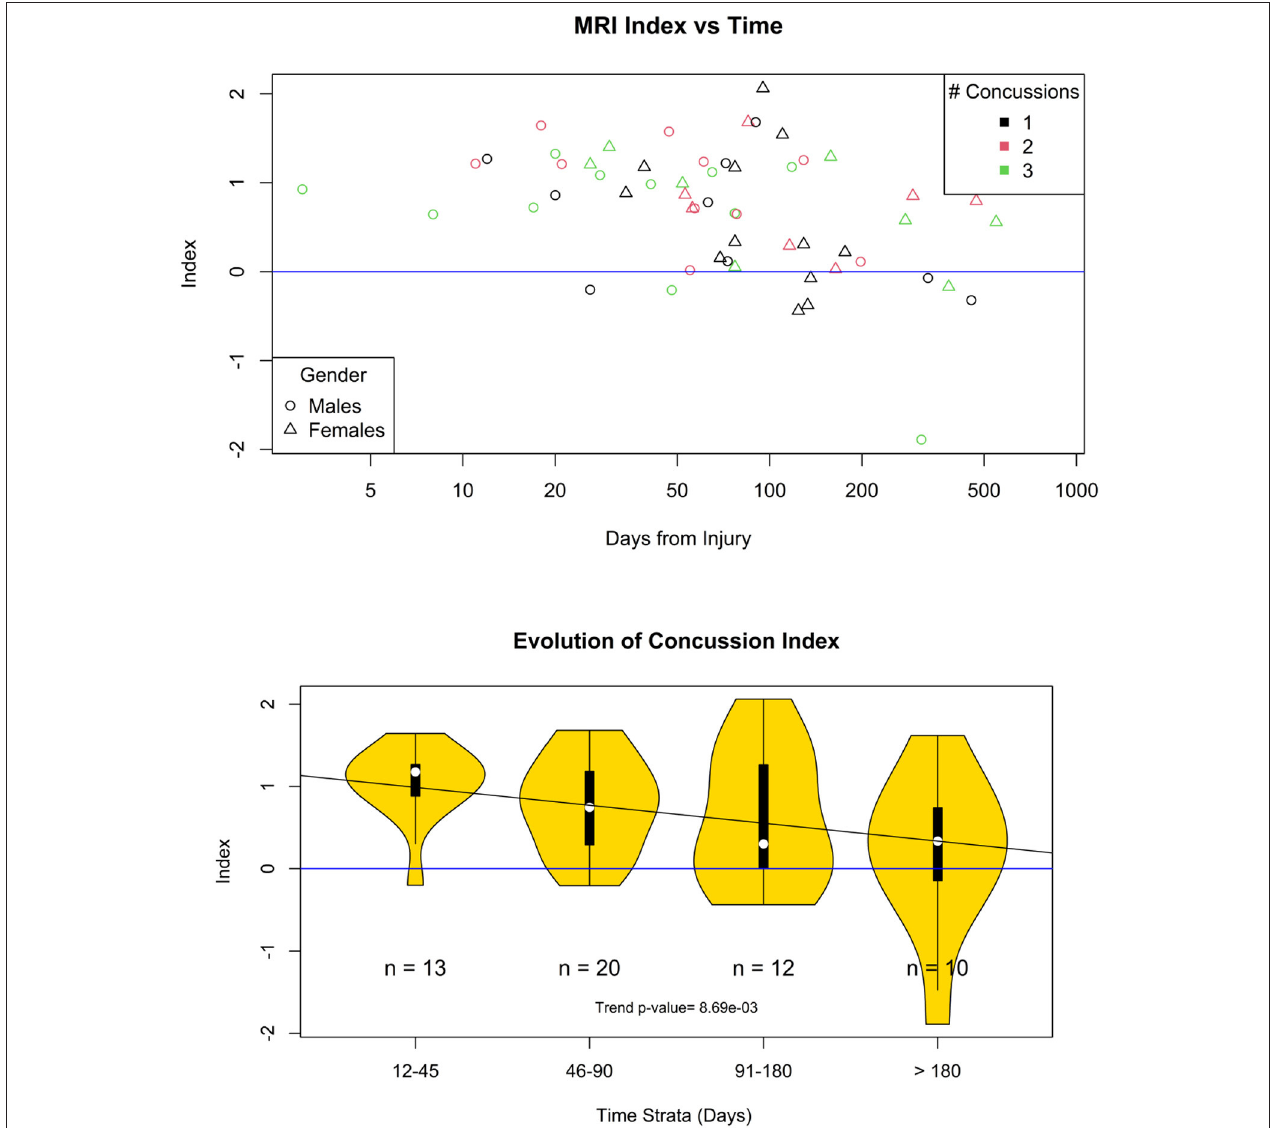
FIGURE 7 | Evolution of the concussion index. Top, scatter plot of the concussion index of each one of the case participants with < 4 concussions. Bottom, the time from injury was divided into four different time strata. The probability that the concuss index is not trending down is